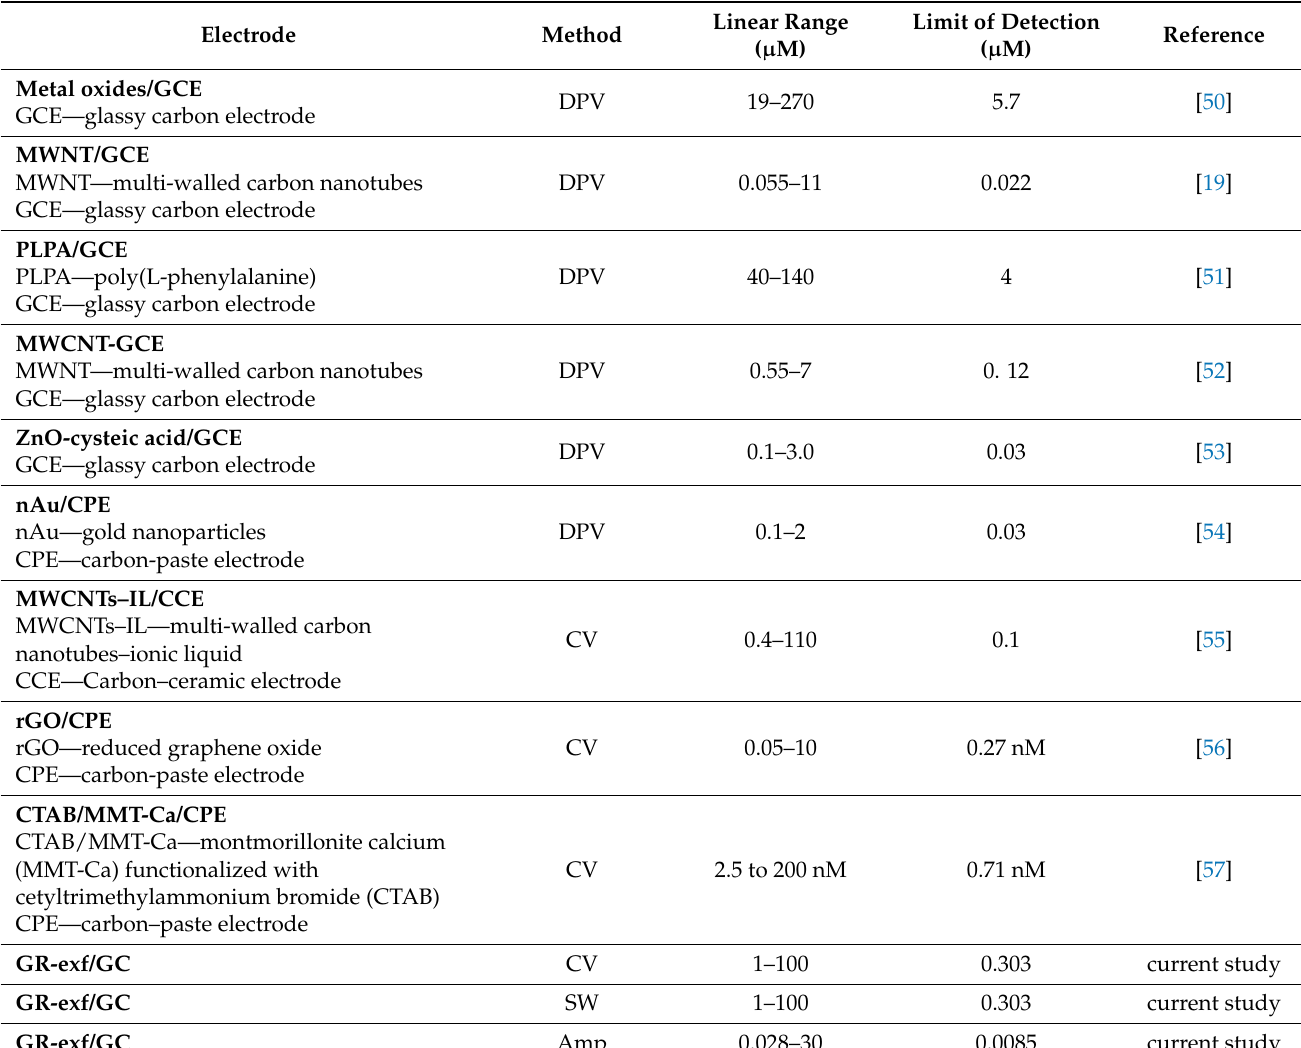
Table 2. Comparison with other reported electrochemical sensors for SY